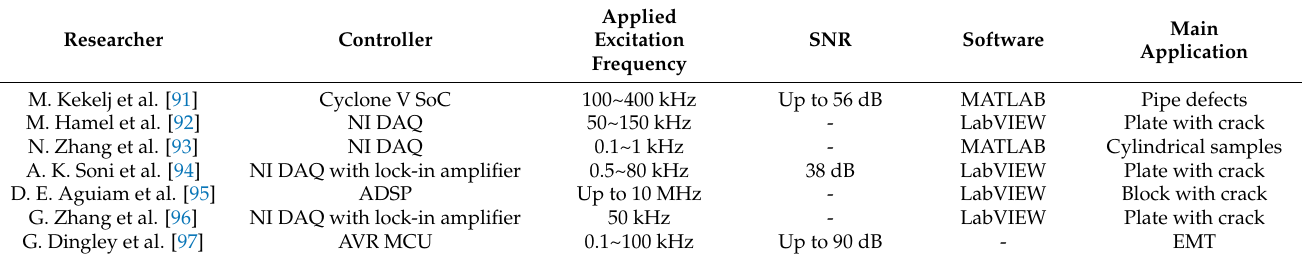
Table 4. Characteristics of customized EC testing instruments in recent studies.